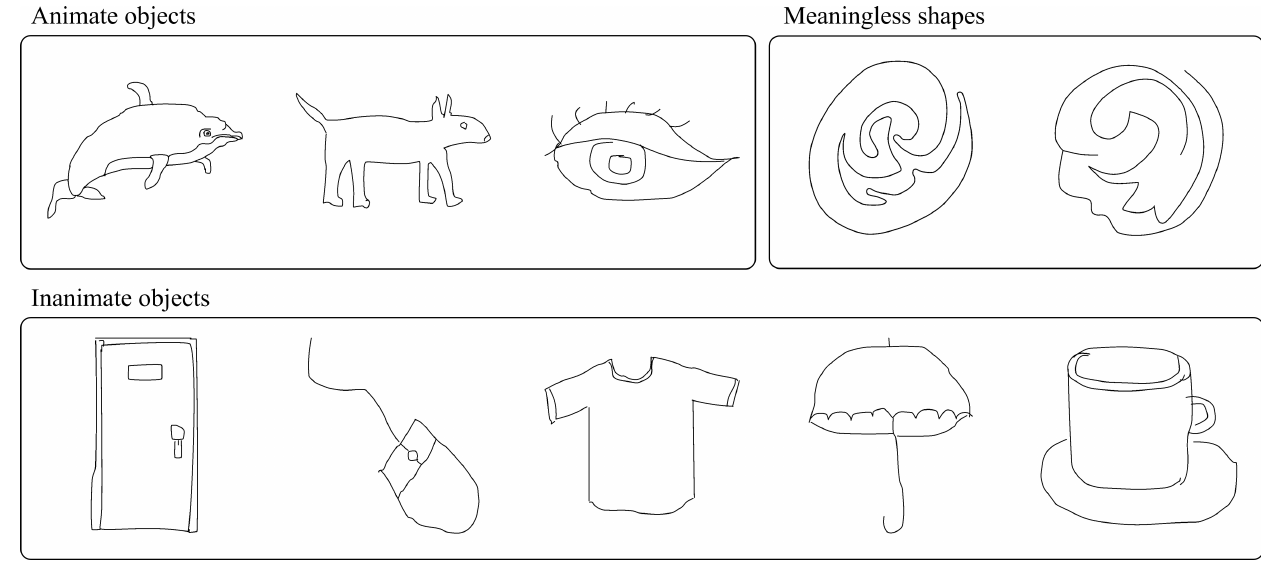
Figure 2. Stimulus images: animate objects (dolphin, dog, and eye), inanimate objects (door, mouse, T-shirt, umbrella, and cup), and meaningless shapes (MS1 and MS2).